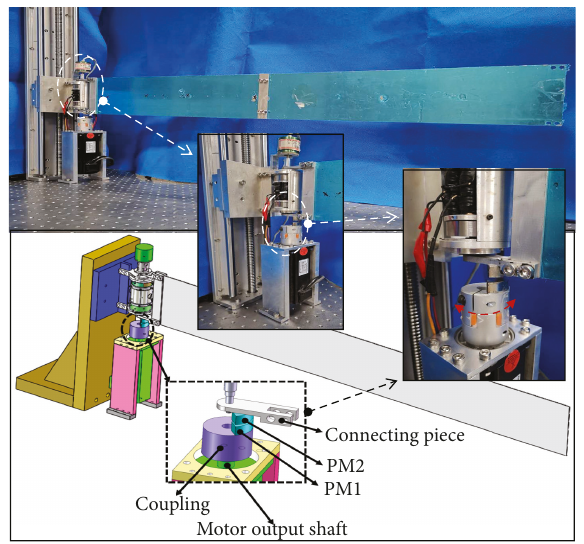
Figure 7: Experiment test setup diagram under electromagnetic noncontact periodic